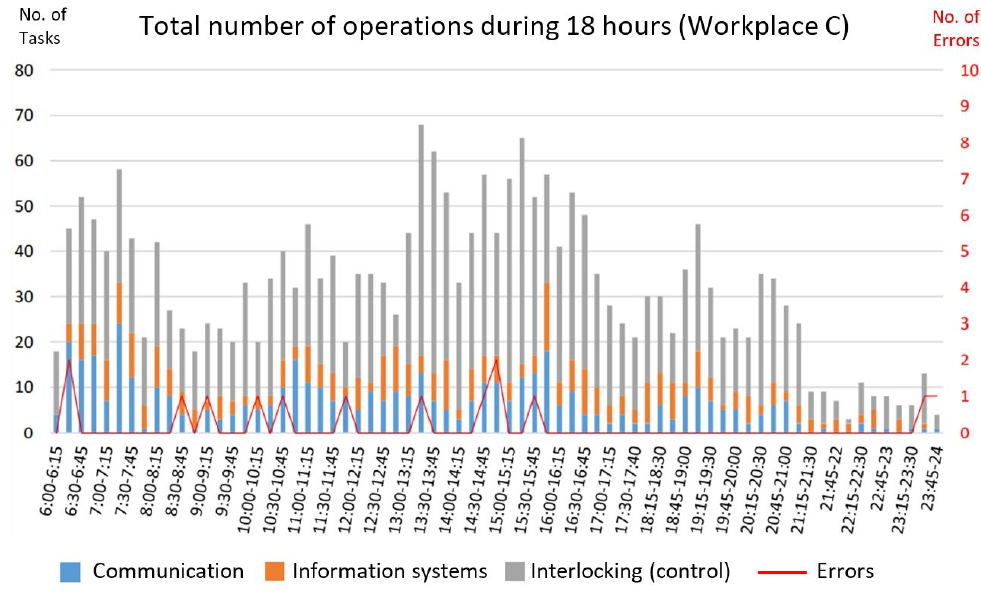
Figure 8. Distribution of operations, tasks and errors over the observed period of 18 h at workplace C.